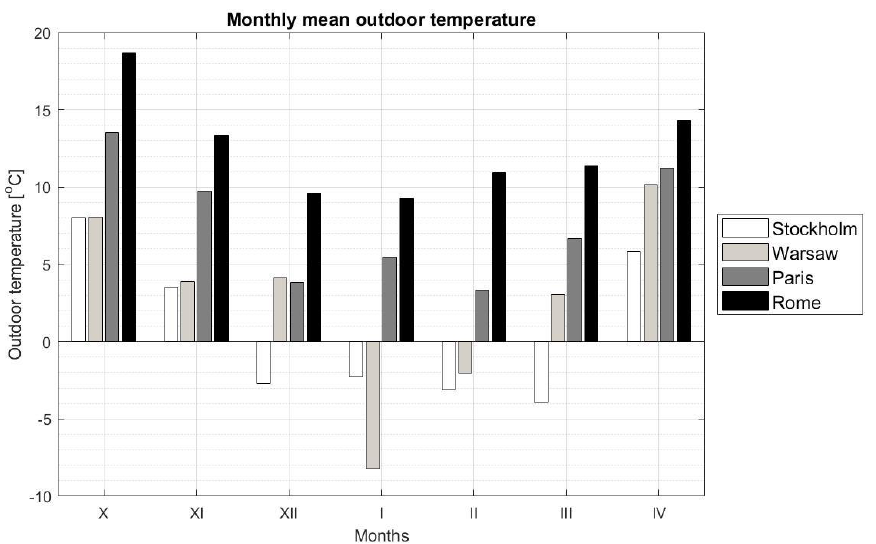
Figure 2. Monthly mean outdoor temperature during the heating period (calculated on the basis of data from [44]).